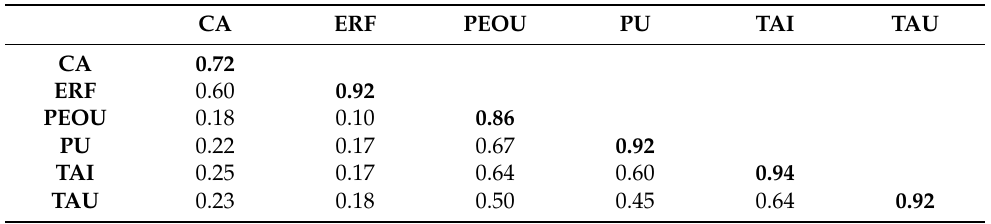
Table 3. Discriminant validity of the constructs. CA